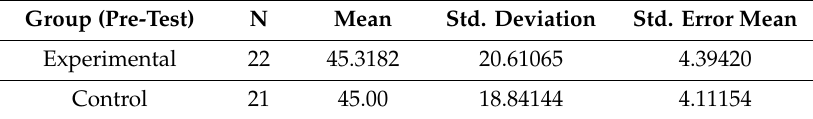
Table 2. Performance statistics before the